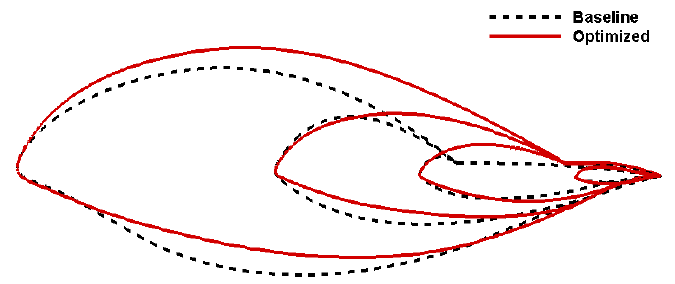
Figure 10 . Baseline and optimized sectional airfoil